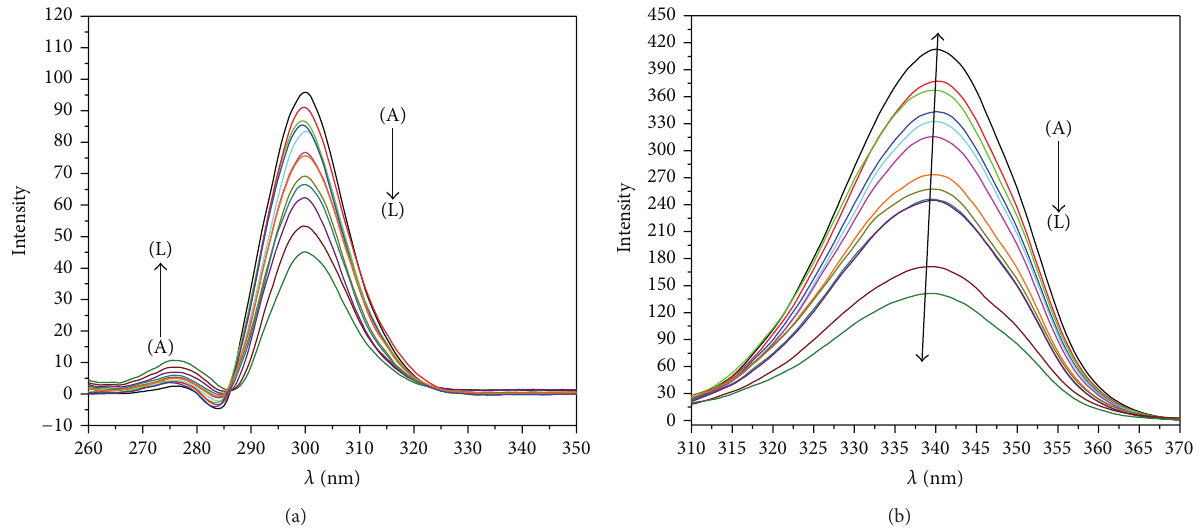
Figure 7: Effect of EVG on the synchronous fluorescence spectra of BSA with Δ𝜆 = 15 nm (A) and Δ𝜆 = 60nm (B). 𝑐 BSA = 50 𝜇 g ⋅ mL −1 , 𝑐 EVG (A–L) = (0, 0.3, 0.7, 1.0, 3.0, 5.0, 10, 12, and 15 𝜇 g ⋅ mL −1 ).